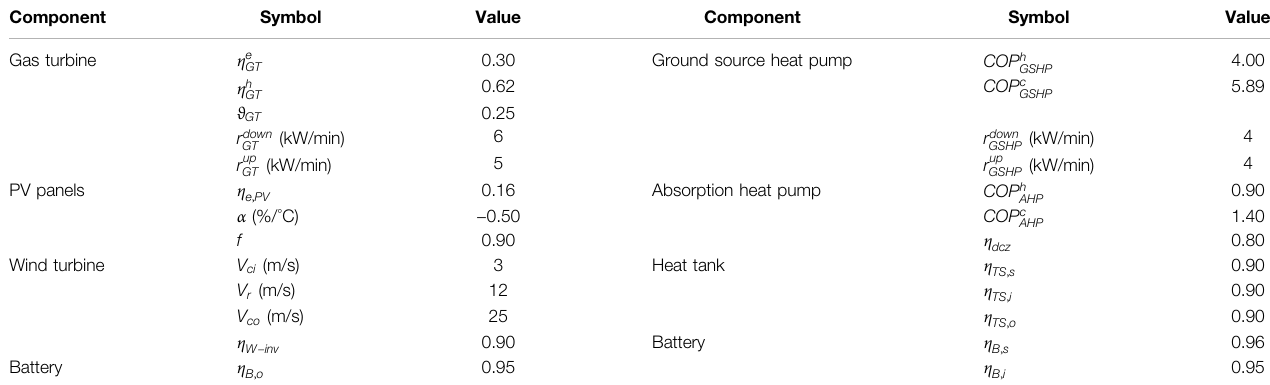
TABLE 3 | Technical parameters